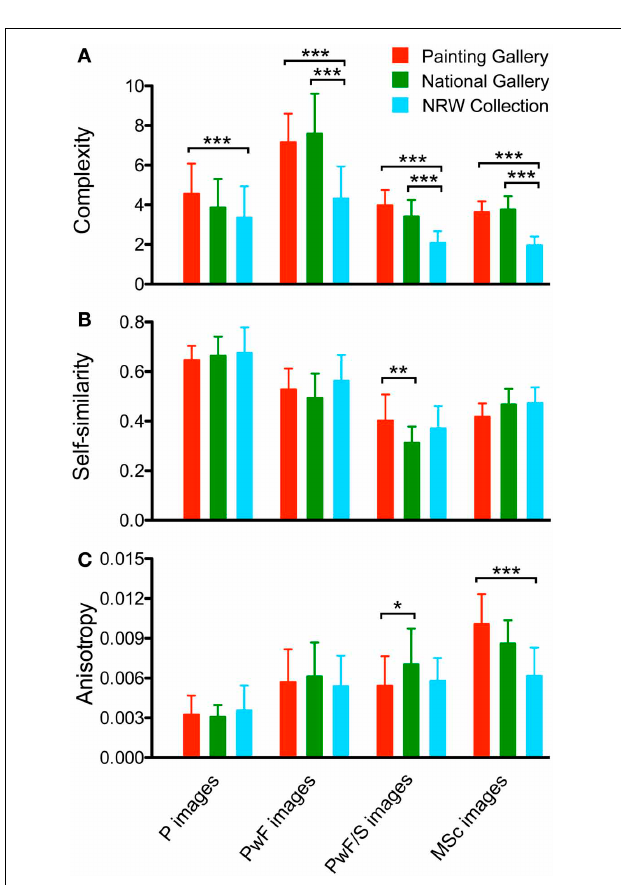
FIGURE 5 | Results for complexity (A) self-similarity (B), and anisotropy (C). The four image categories analyzed are indicated at the bottom of the figure for all panels. Values represent the mean ± 1 SD . Colors indicate the different museums, as indicated in (A) . Differences are significant at p < 0 . 05 ( ∗ ), p < 0 . 01 ( ∗∗ ) and p < 0 . 001 ( ∗∗∗ ), as shown. Significance levels are shown for comparisons within image categories